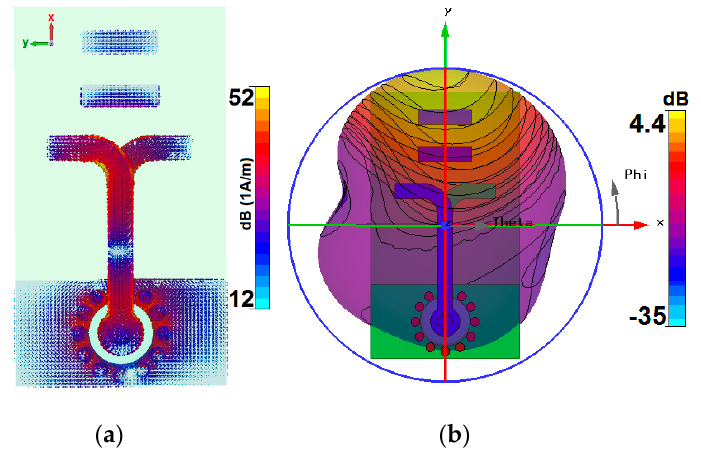
Figure 3. S 11 results of the Quasi-Yagi antenna for different values of (a) W (width of the antenna arm), (b) L g (length of the ground plane), and (c) W 1 (length of the directors).